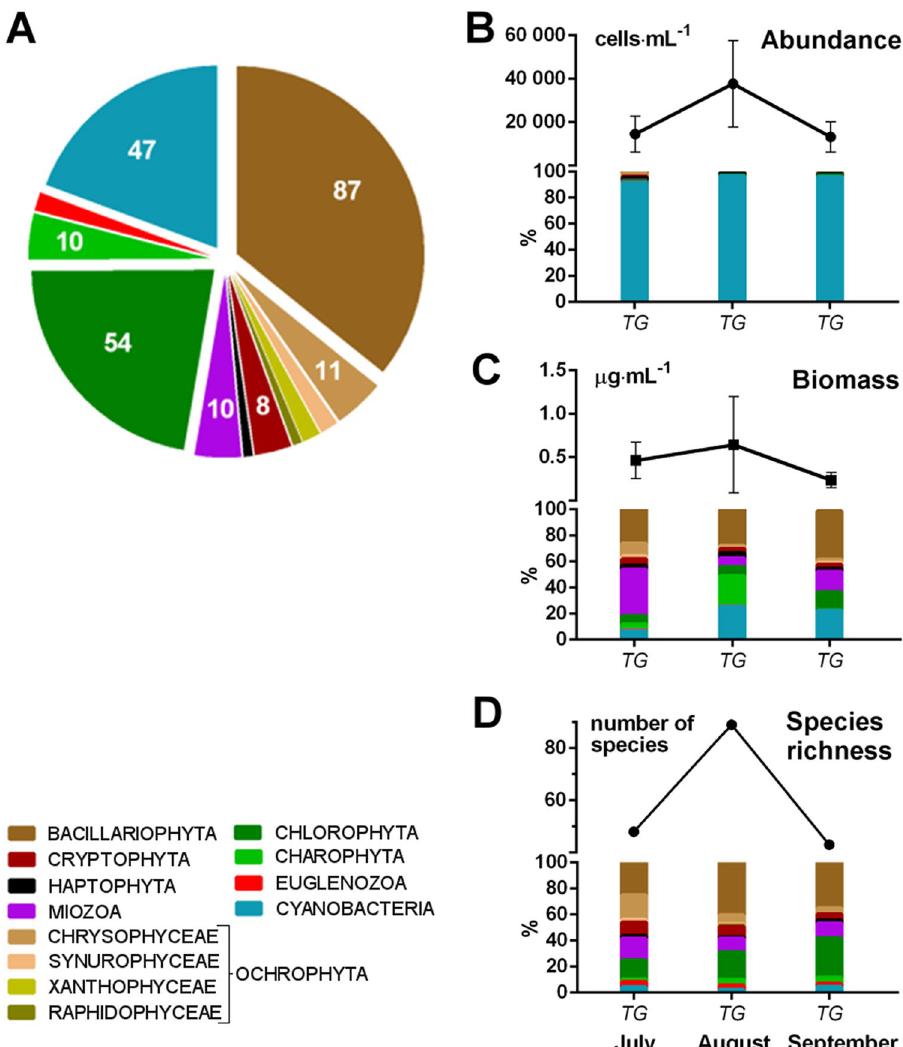
Figure 3. Community composition of phytoplankton in Lake Burabay. ( A ) Contribution of species belonging to major taxonomic groups; ( B ) total and relative abundance of taxonomic groups; ( C ) total and relative biomass of taxonomic groups; ( D ) total and relative species’ number of taxonomic groups. Mean values ± Std